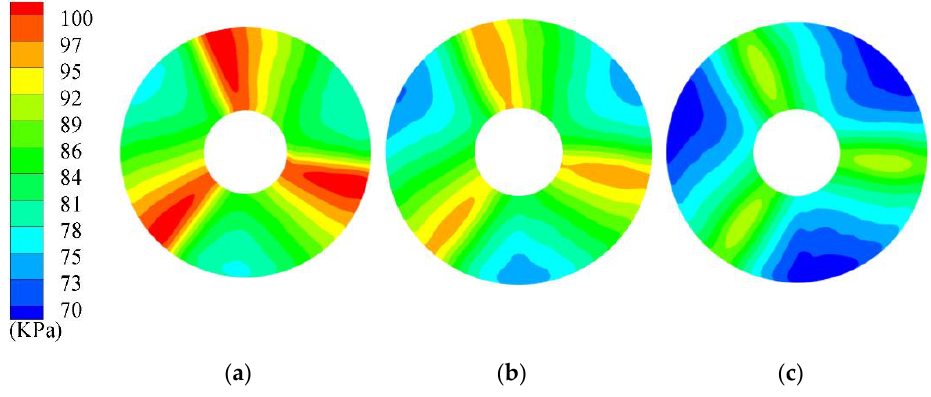
Figure 9. Pressure distribution of impeller inlet: ( a ) Q = 0.8 Q bep ; ( b ) Q = 1.0 Q bep ; ( c ) Q = 1.2 Q bep .